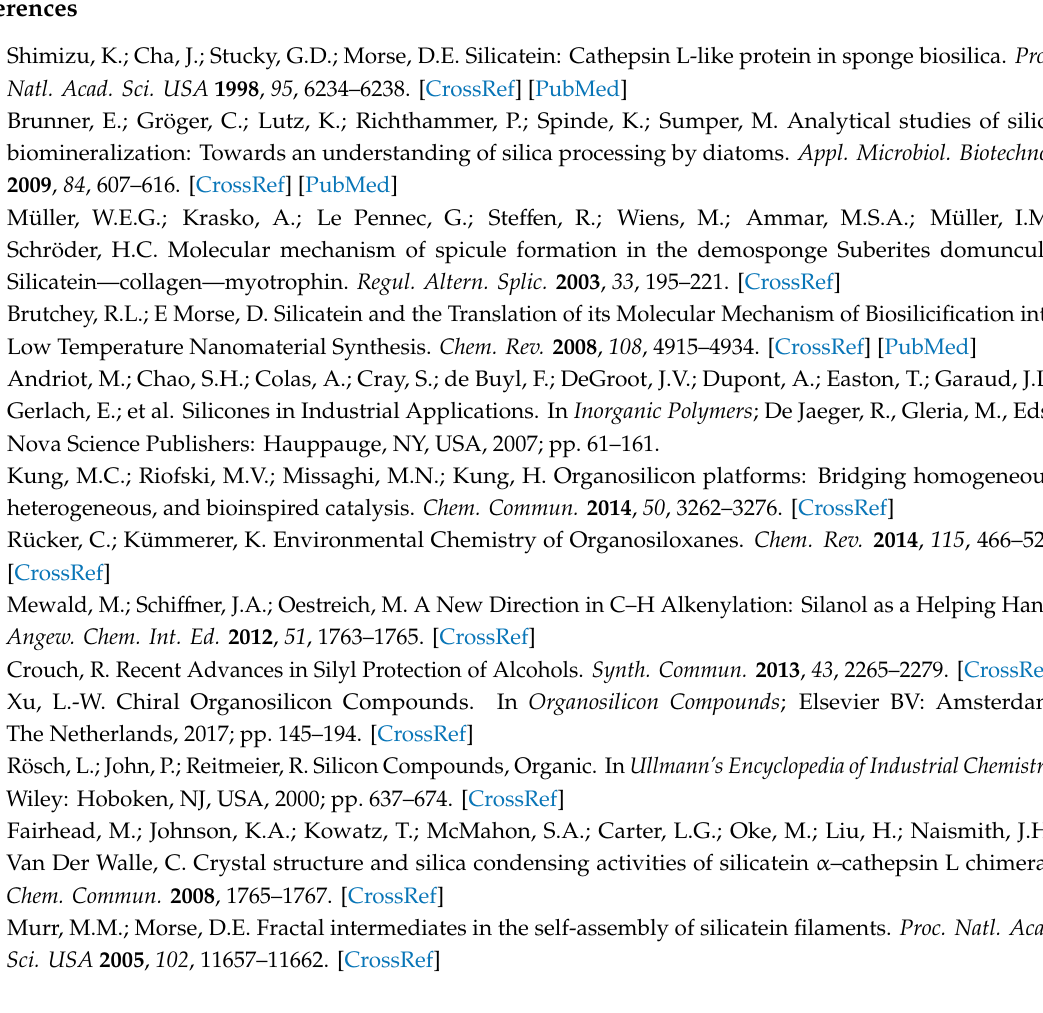
Figure S1: Images of SDS-PAGE gels demonstrating solubility analysis for His 6 -Sil α , Figure S2: Michaelis-Menten kinetics for TF-Sil α -Strep using the TBDMS-ONp